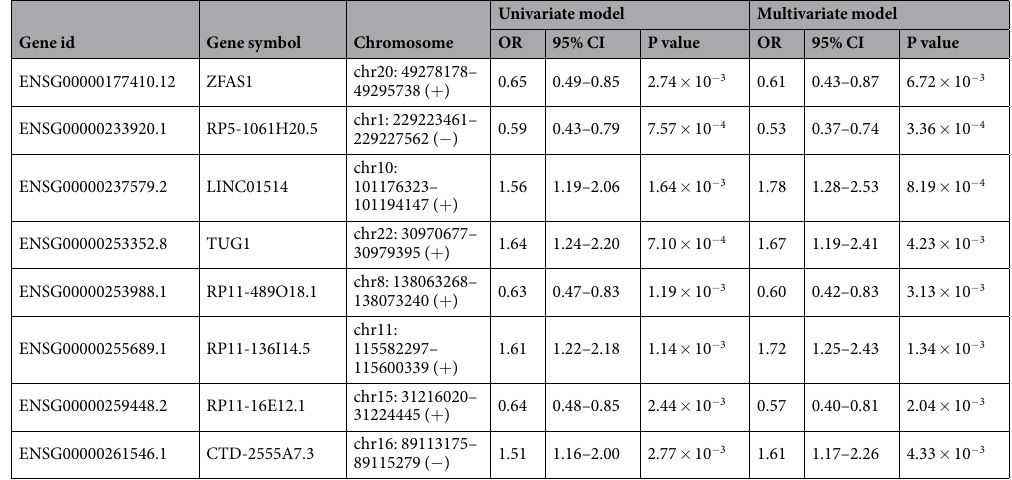
Table 1. Logistic regression model for chemosensitive patients with complete clinical and genomic data in the training dataset (n =